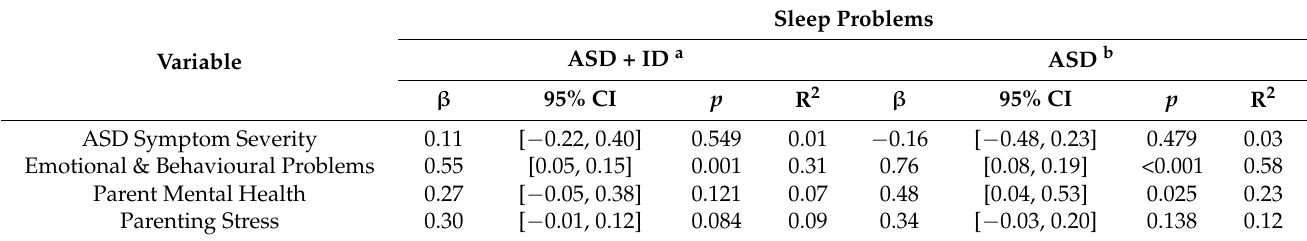
Table 4. Unadjusted Associations between Child Factors, Parent Factors and Child Sleep Problems.